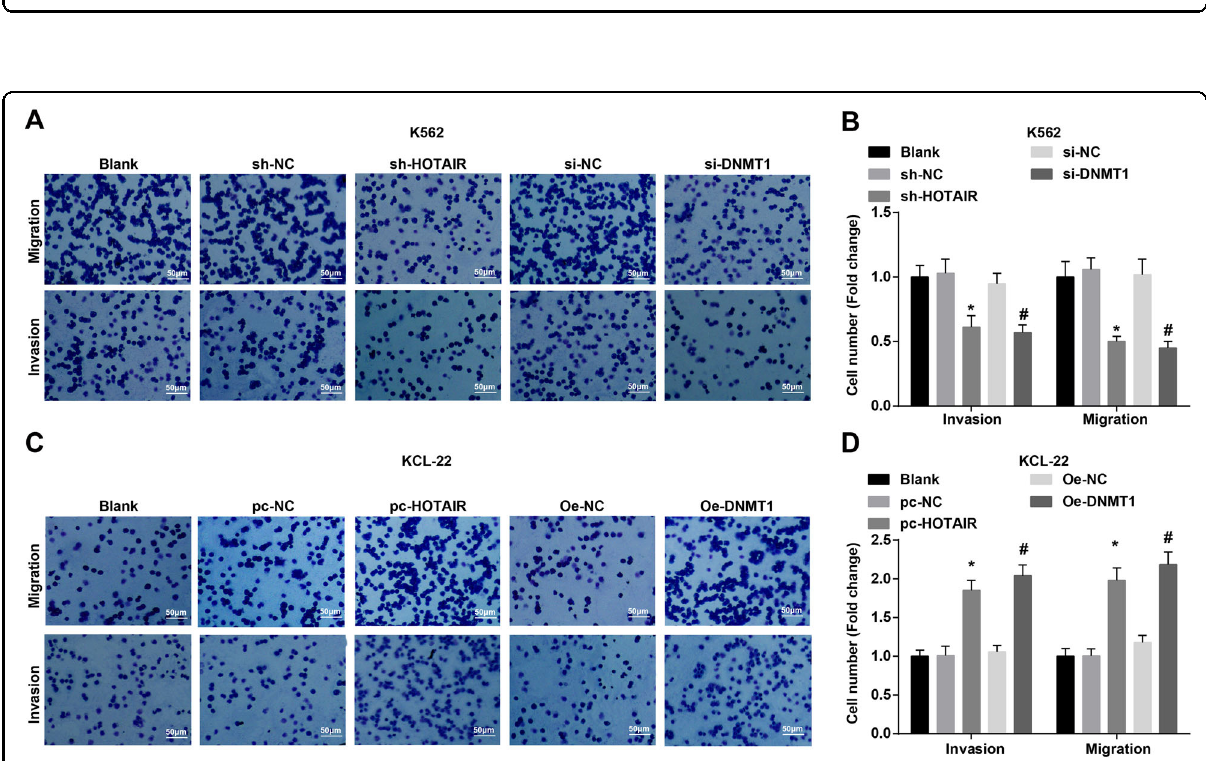
Fig. 4 Depleted HOTAIR or DNMT1 attenuates invasion and migration of CML cells. A Invasion and migration of K562 cells in each group. B Invasion and migration of K562 cells in each group. C Invasion and migration of KCL-22 cells in each group. D Invasion and migration of KCL-22 cells in each group. In K562 cells, * P < 0.05 vs. the sh-NC group, # P < 0.05 vs. the si-NC group. In KCL-22 cells, * P < 0.05 vs. the pc-NC group, # P < 0.05 vs. the OE-NC group. N = 3. Measurement data were depicted as mean ± standard deviation. Comparisons among multiple groups were assessed by one-way ANOVA followed by Tukey ’ s multiple comparisons